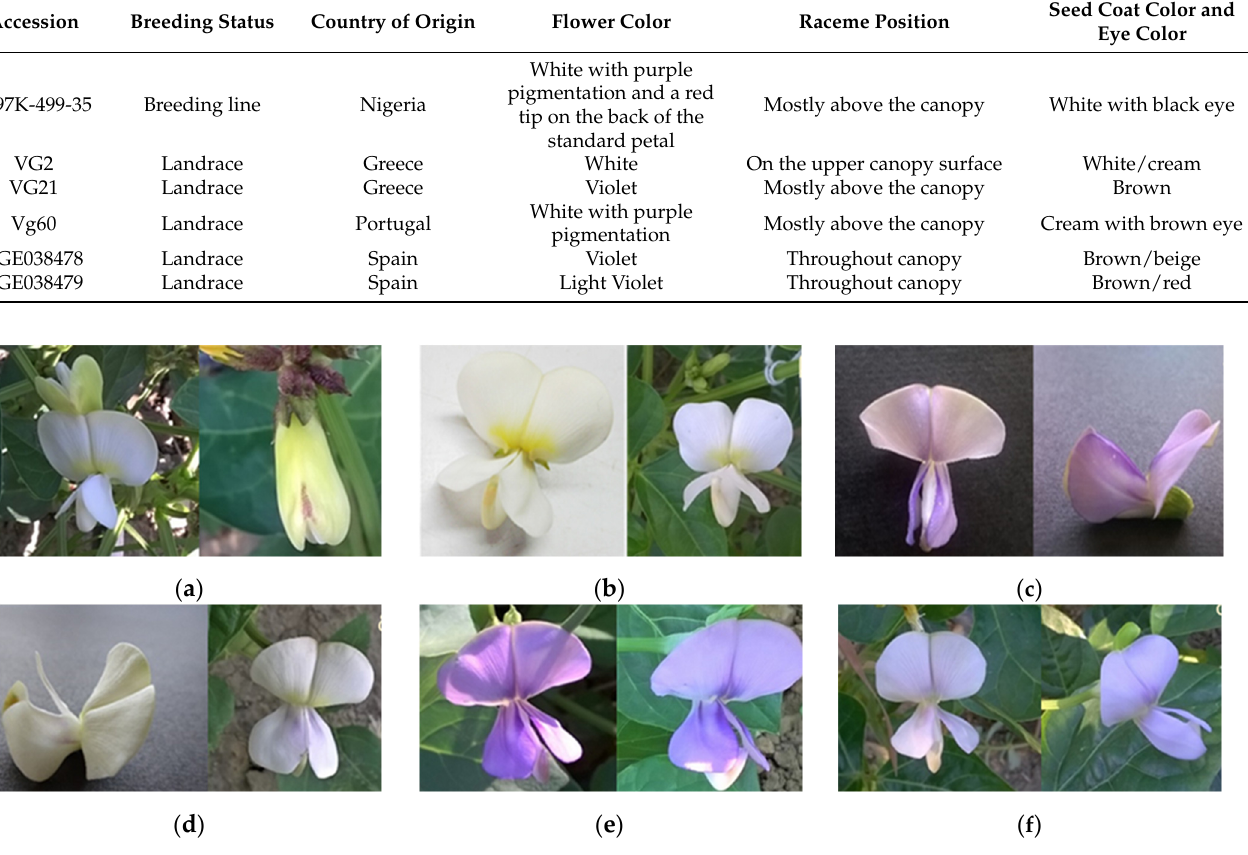
Figure 1. Flower color of the plant material used, where: ( a ) flowers of breeding line IT97K-499-35, ( b ) flowers of local population VG2, ( c ) flowers of local population VG21, ( d ) flowers of local population Vg60, ( e ) flowers of local population BGE038478, and ( f ) flowers of local population BGE038479.